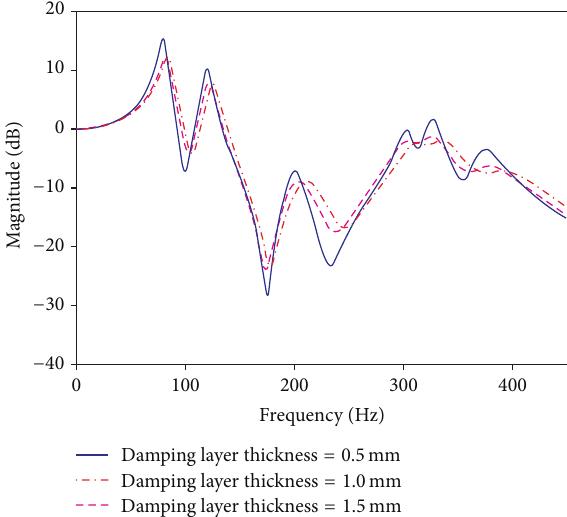
Figure 3: Frequency response functions of fiber reinforced cylindri- cal composite panel with variation of thickness of damping